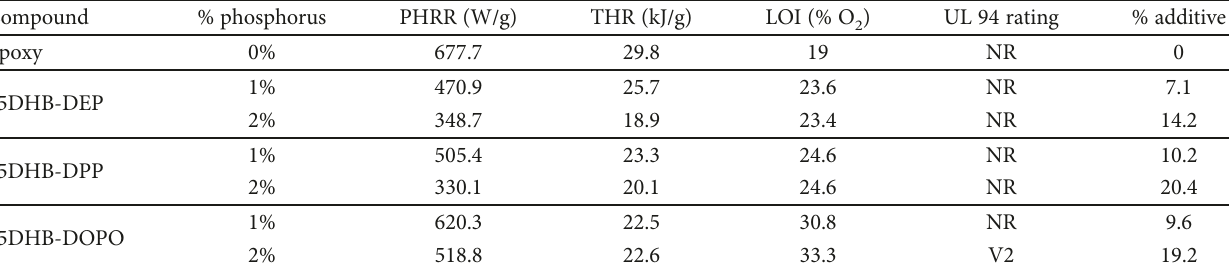
Table 8: Flammability characteristics for blends of phosphorus esters of methyl 3,5-dihydroxybenzoate with DGEBA epoxy.